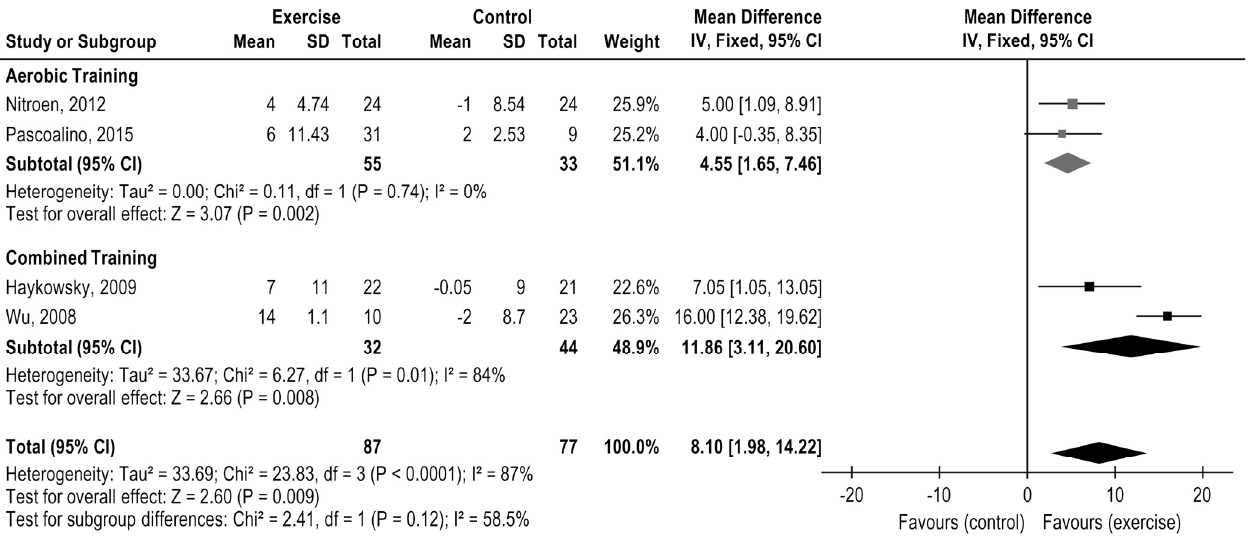
Figure 3. Impact of exercise training on Heart Rate peak (bpm) in HTx: exercise versus the control group